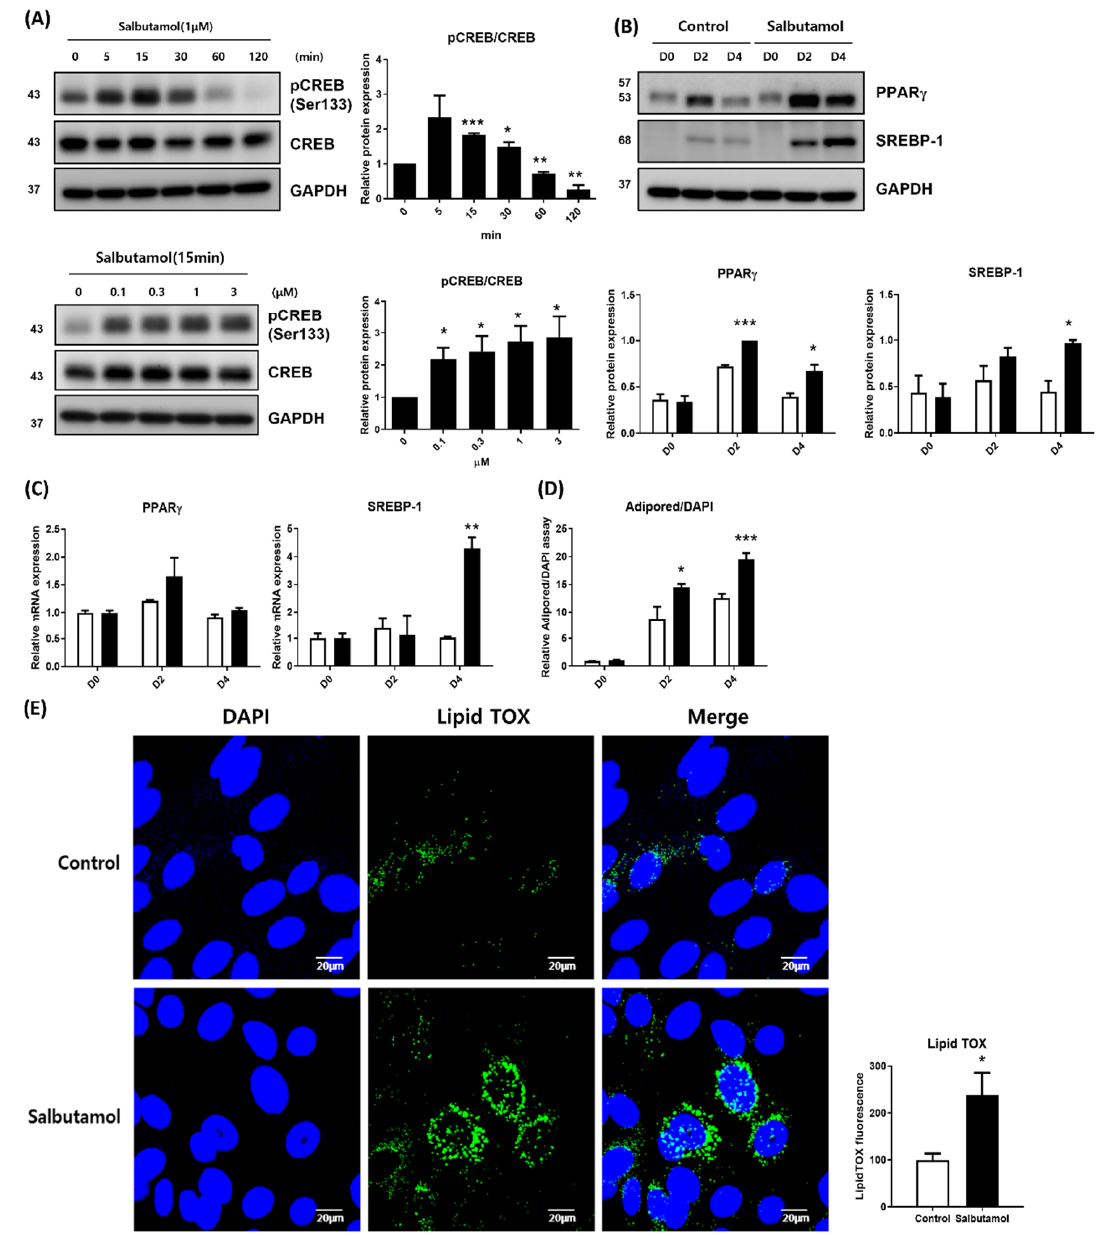
Figure 3. Beta 2-adrenergic agonist activates PKA signaling pathway, followed by promoted PPAR γ expression and lipid droplet synthesis. ( A ) HMGECs were treated with salbutamol and phosphorylation of CREB at ser133 residue, which was assessed by immunoblotting in serial and dose escalation manners. After treatment with salbutamol (1 μ M), the CREB phosphorylation was assessed with time. CREB phosphorylation was highest at 15 min after treatment and decreased thereafter. After salbutamol was treated by concentration, CREB phosphorylation was examined 15 min later. CREB phosphorylation increased with salbutamol concentration. ( B – E ) HMGECs were cultured with or without salbutamol (1 μ M; salbutamol was treated at day 0 and 2). ( B , C ) Transcription and protein expression of PPAR γ and SREBP-1 were assessed by quantitative PCR and immunoblotting at day 0, 2, and 4. ( D , E ) Lipid synthesis was measured by AdipoRed assay and LipidTOX assay at day 4. All results are the sum of three independent experiments. Data are presented as the mean ± standard error of the mean. D, day after differentiation; * p < 0.05; ** p < 0.01; *** p < 0.001.